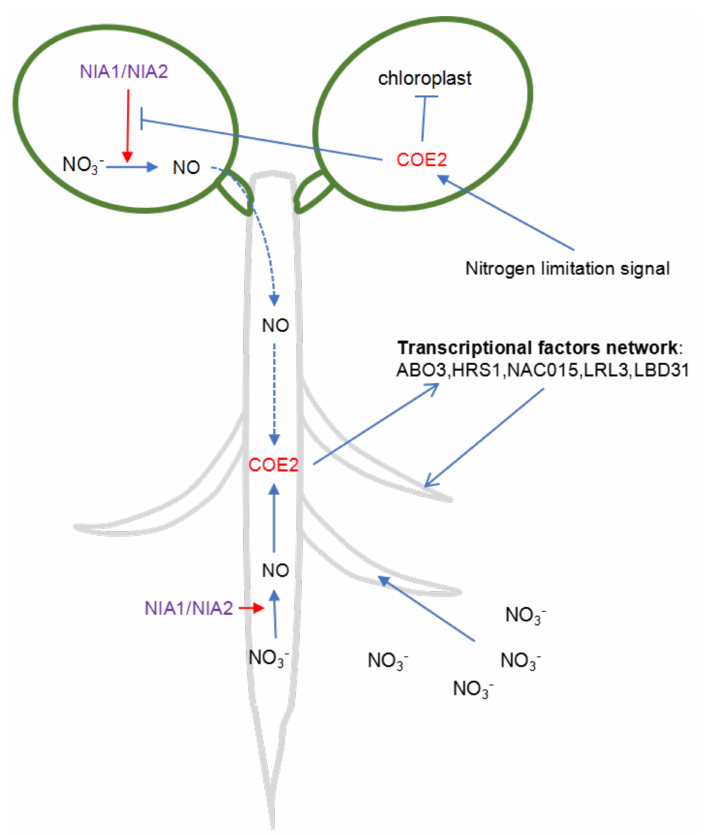
Figure 10. Model showing how COE2 regulates root development in response to nitrogen